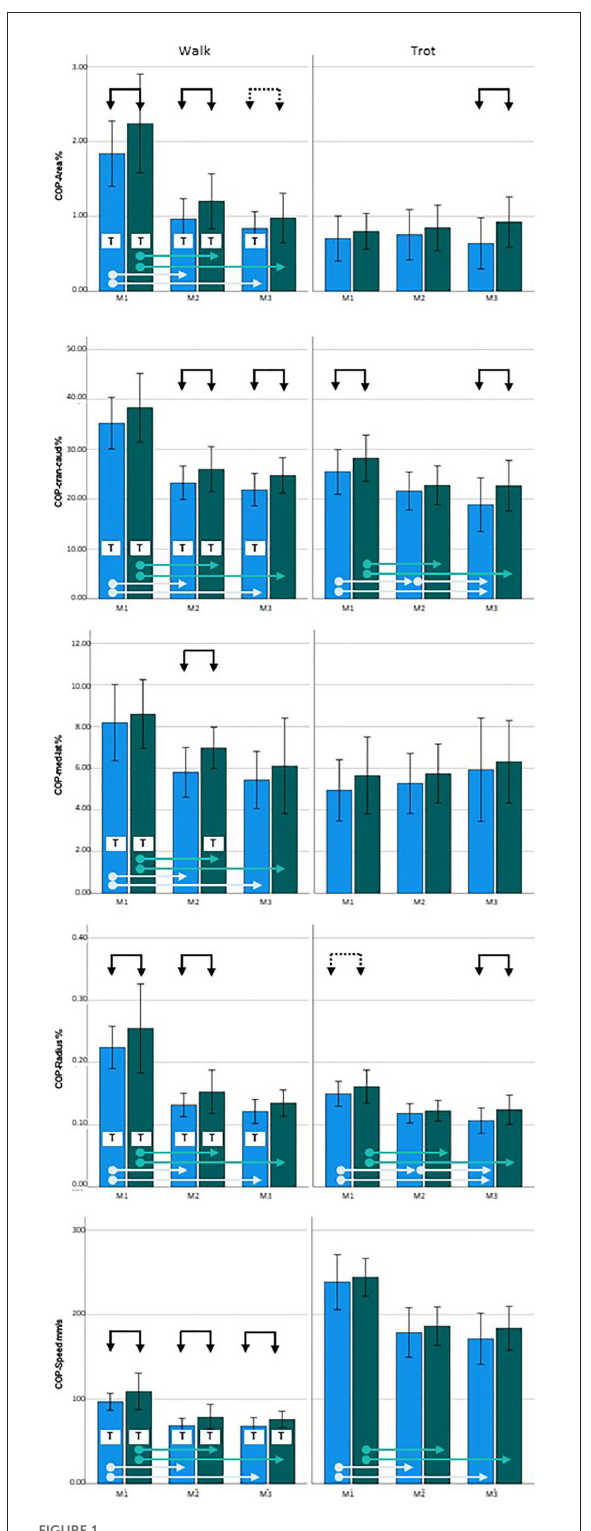
FIGURE1 Center of pressure (COP) data for Labrador Retrievers: Left = walking, right = trotting; blue = soundlimbs, green =